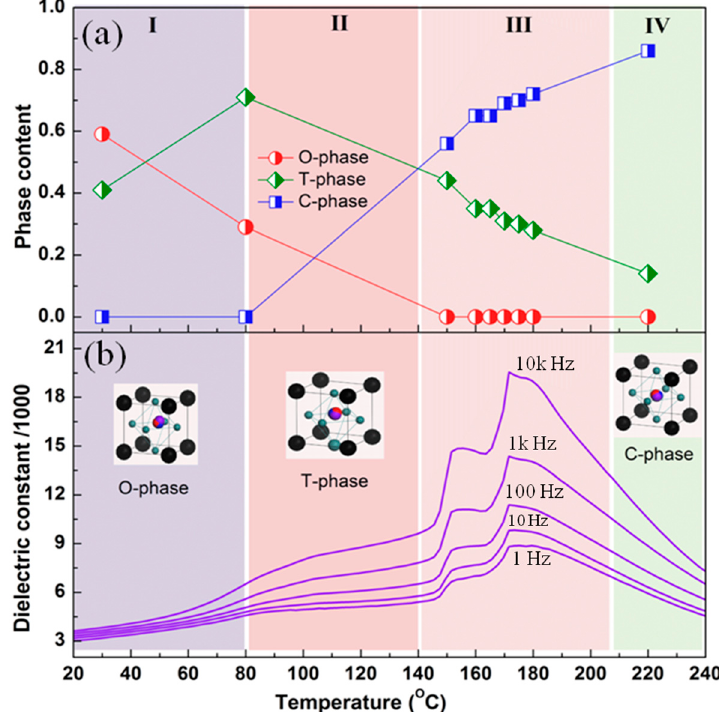
Figure 2. ( a ) The evolution of different phases in PZN-9PT. Four regions with different amounts of phases could be clearly distinguished; ( b ) The temperature dependence of the dielectric constant of PZN-9PT at selected frequencies (1, 10, 100, 1000, and 10,000 Hz).